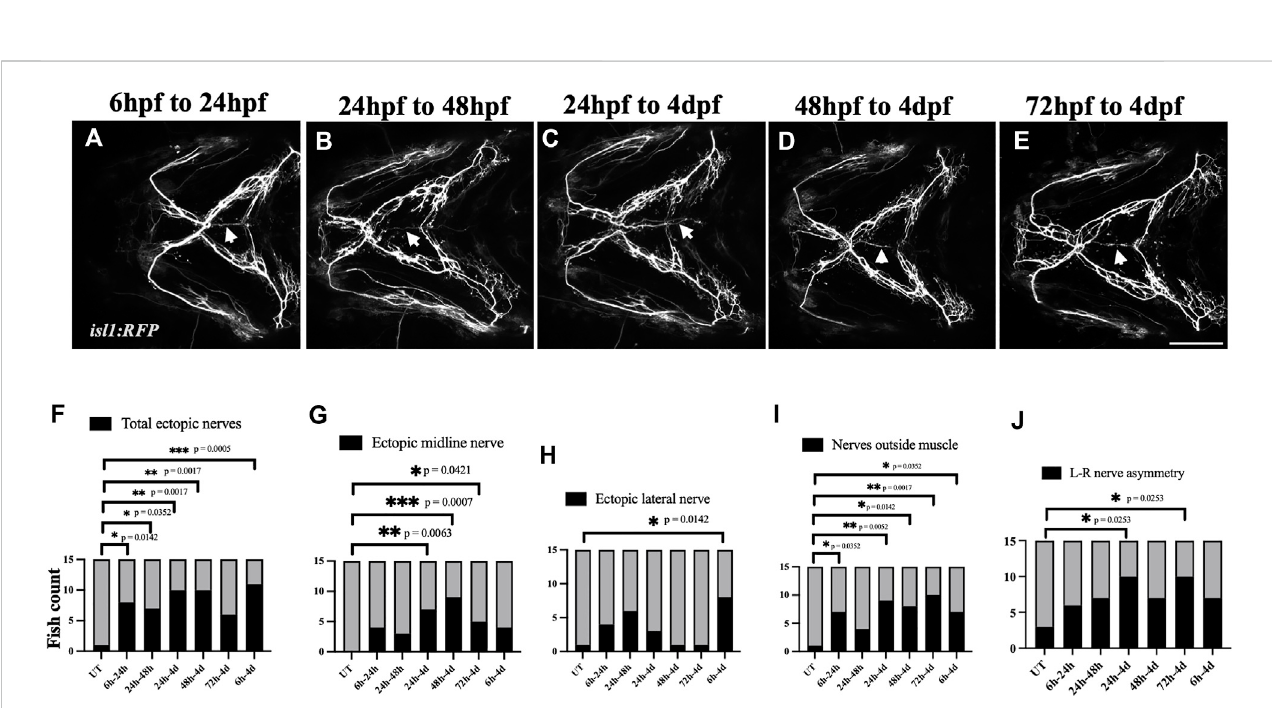
FIGURE 9 Ethanol-induced nerve defects occur at the time of muscle innervation (A – E) 1% ethanol exposure between 6hpf-24hpf, 24hpf-48hpf, 24hpf-4dpf, 48hpf-4dpf and 72hpf-4dpf result in ectopic nerve defects. Arrows indicate ectopic nerves along the medial axis. (F – J) Number of ethanol-exposed isl1:RFP fi sh with total ectopic nerves, ectopic midline nerves, ectopic lateral nerves, nerve positioned outside the muscle, left-right nerve asymmetry ( n = 15 in each group).The frequencyofvarious nervedefects signi fi cantly increasedin fi shexposed toethanol between 24 h-4 dand 48 h-4 d. (F,G)Thefrequencyof ectopic nerve defects particularly increased in fi sh exposed to ethanol between 48 h and 4 d. (h/hpf-hours post fertilization, d-days post fertilization). * = p < 0.05; ** = p < 0.01; *** = p < 0.001. Scale bar = 100 um.